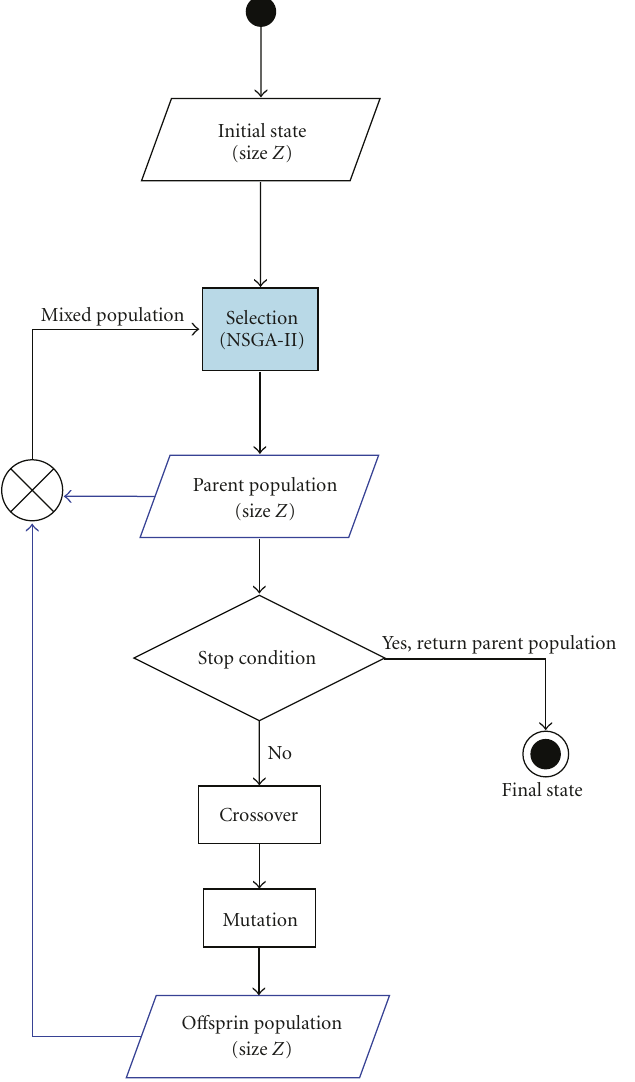
Figure 2: Proposed evolutionary optimization to solve the DSSB problem.